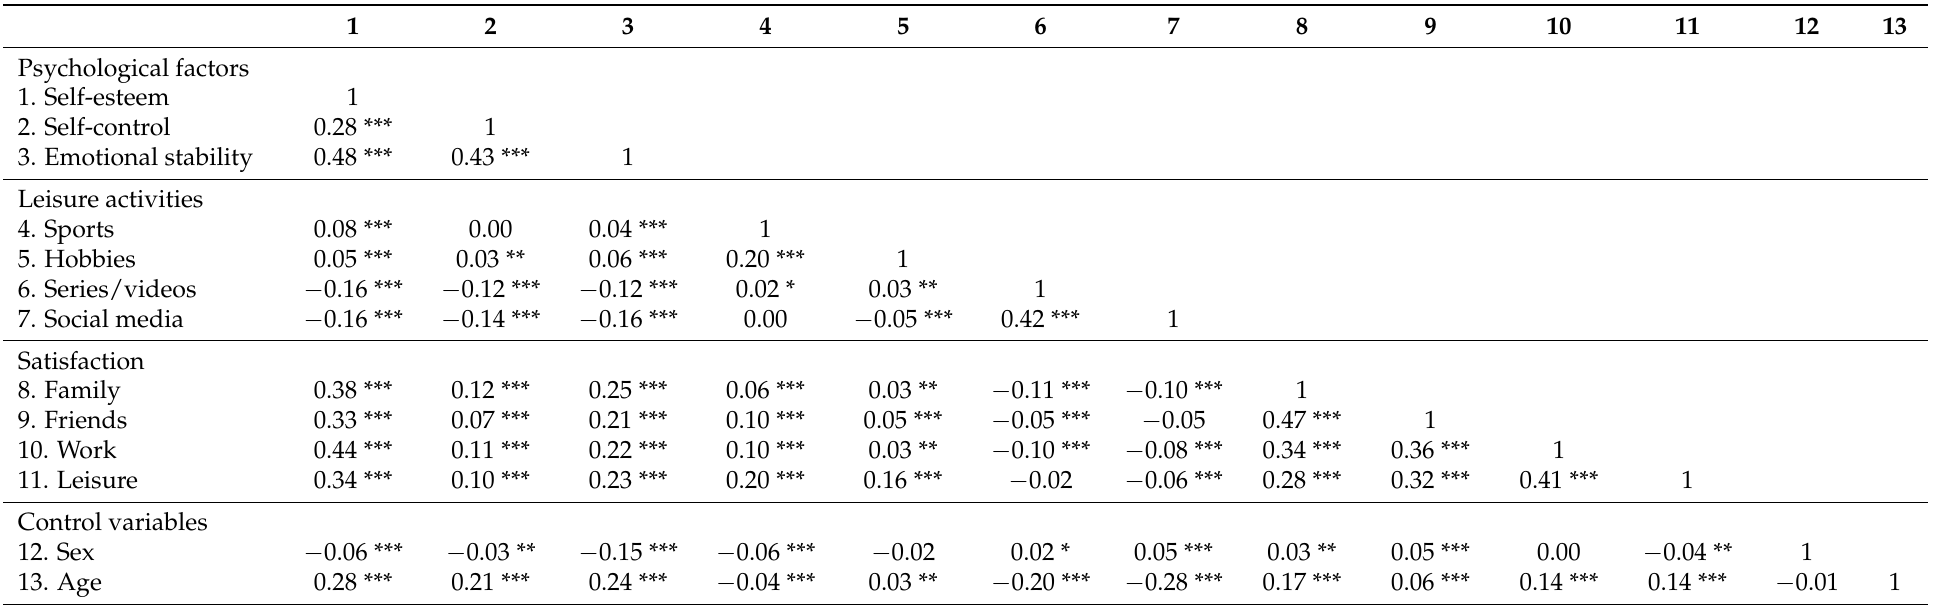
Table 3. Bivariate correlations between psychological factors, leisure activities, and